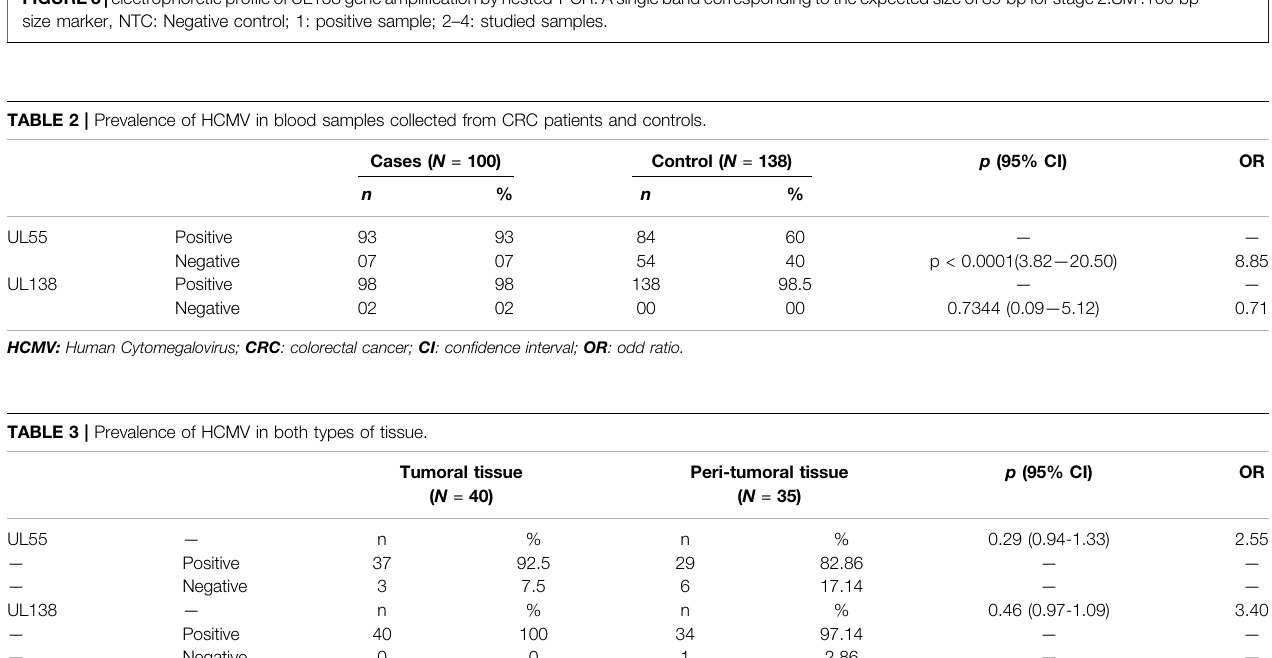
Tumoral tissue ( N = 40)